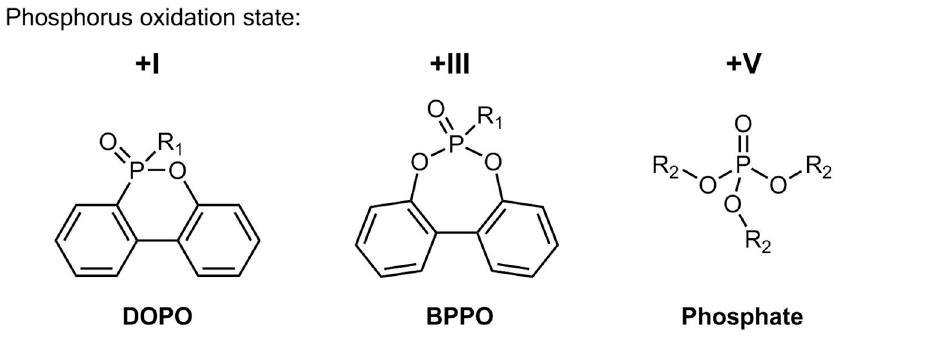
Figure 1. Chemical structures of 9,10-dihydro-9-oxy-10-phosphaphenanthrene-10-oxide (DOPO), dibenzo[d,f][1,3,2] dioxaphosphepine 6-oxide (BPPO), and the descibed phosphates with the assigned oxidation state of the phosphorus atom.